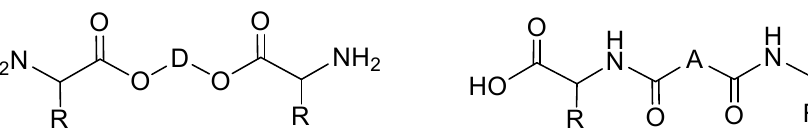
Figure 18. Two types of AA based monomers—bis-nucleophilic AAAD and bis-electrophilic DABA. R, side chain of AA; D, diol residue; A, Diacid residue.